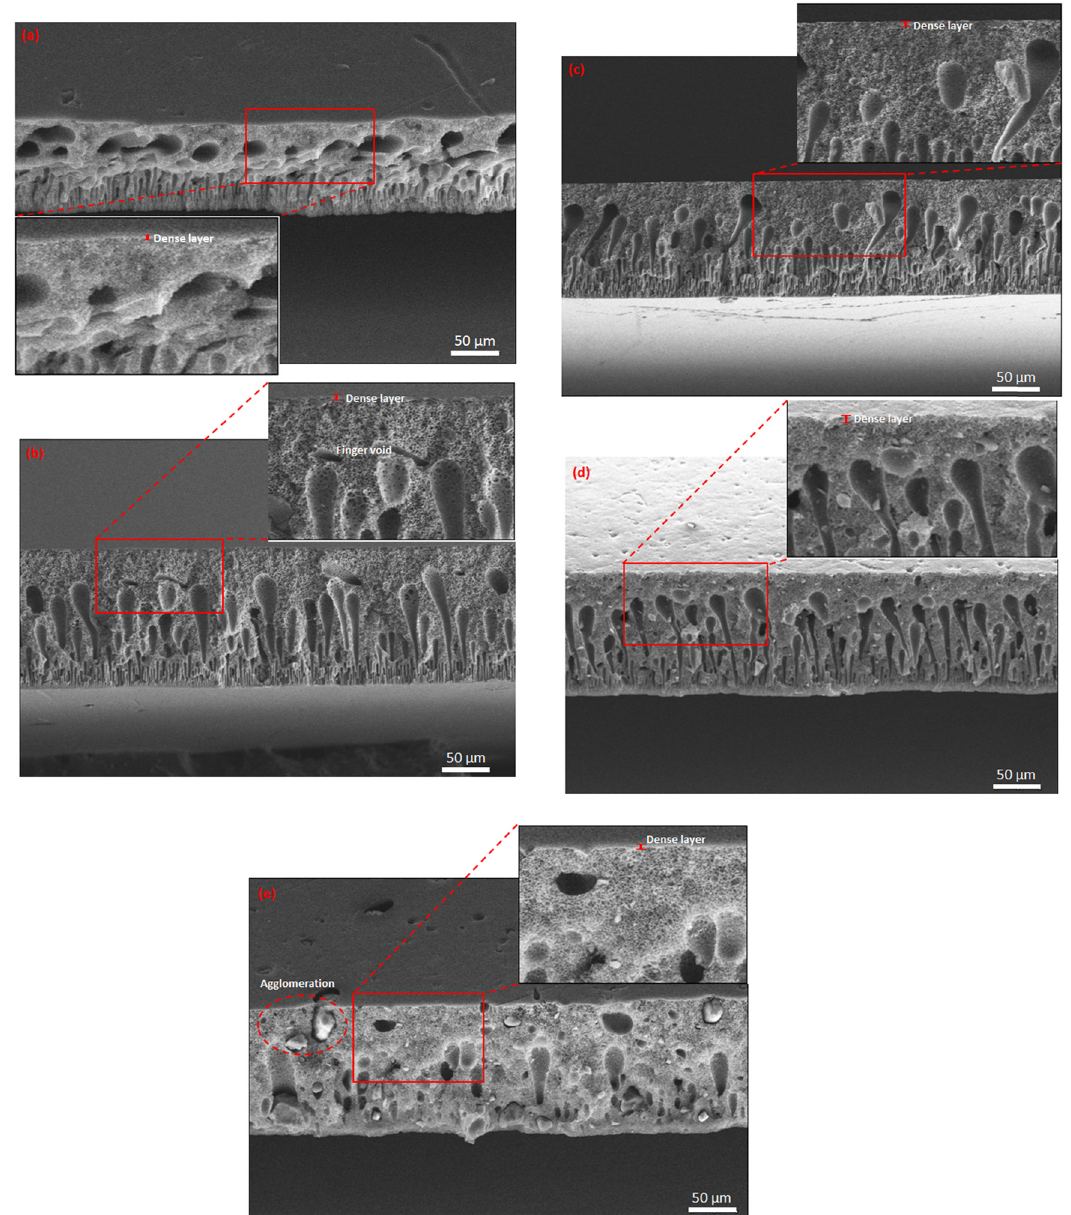
Figure 7: Cross - section of morphological appearance of ( a ) PES, ( b ) PES/MIL - 100 ( Al ) 5%, ( c ) PES/MIL - 100 ( Al ) 10%, ( d ) PES/MIL - 100 ( Al ) 20%, and ( e ) PES/MIL - 100 ( Al )